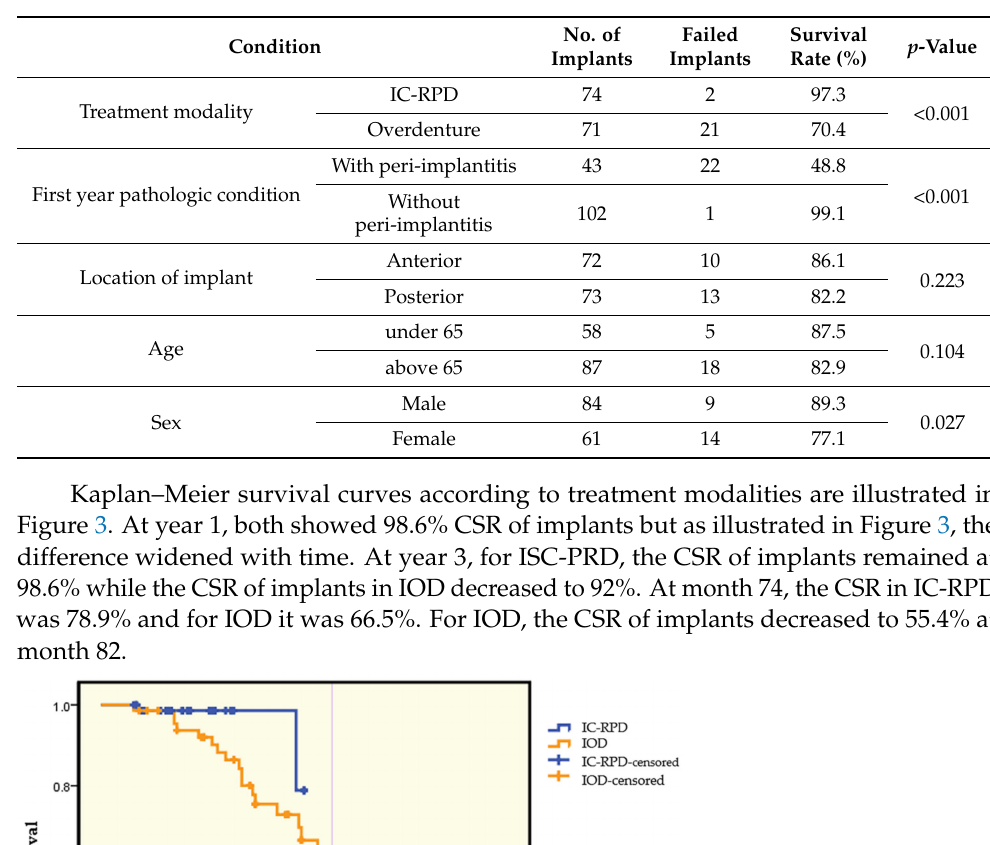
Table 3. Survival rates of implants and p -values according to variables.